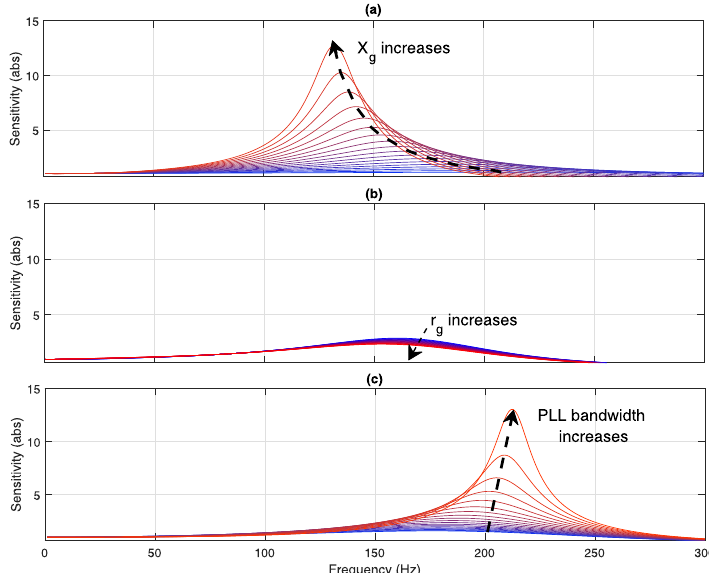
Figure 4. System sensitivity functions as ( a ) inductive grid reactance increases, ( b ) grid resistance increases, and ( c ) PLL bandwidth